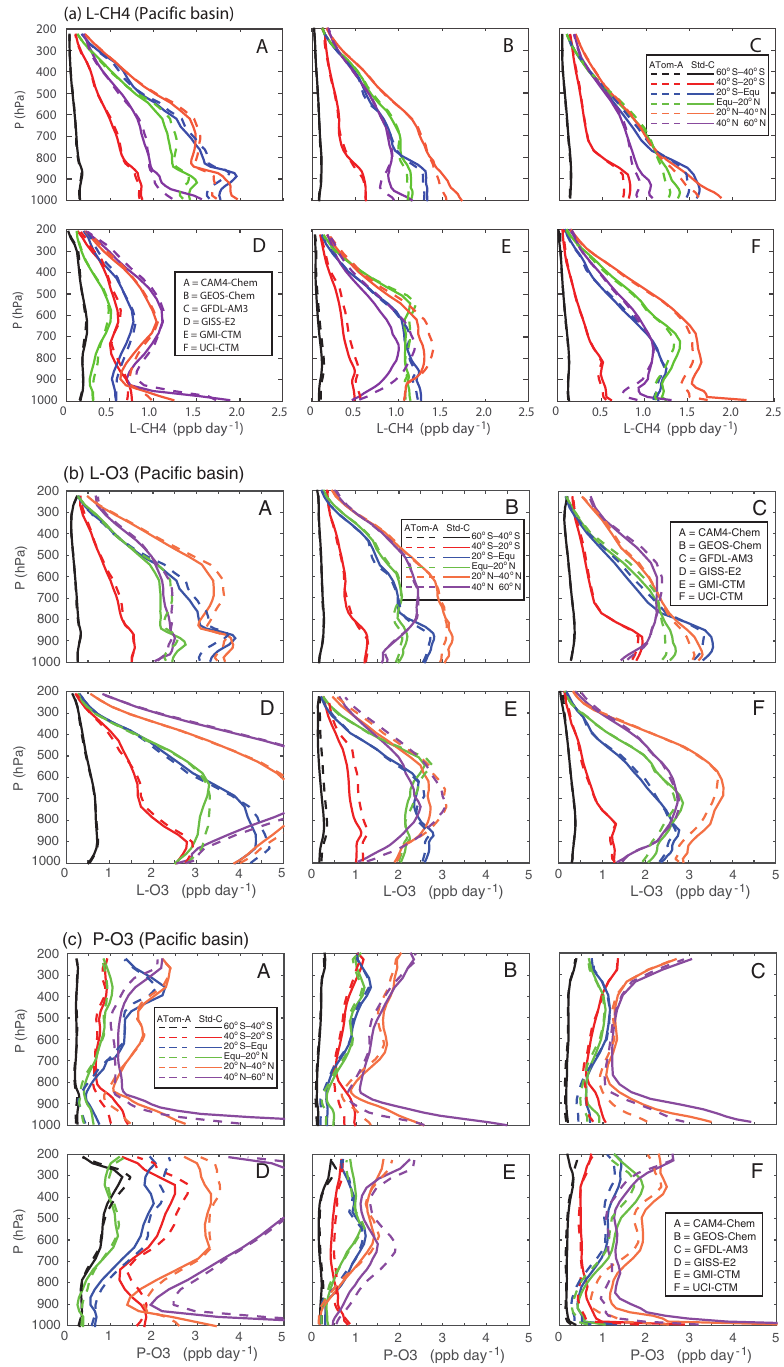
Figure 3. Profiles of reactivity (ppb day − 1 ) for loss of CH 4 (L-CH4, top panel), loss of O 3 (L-O3, middle panel), and production of O 3 (P-O3, bottom panel) from six global models (Table 1). Cells from each model grid are averaged over 20 ◦ latitude domains (different colors, see legend), longitudes from 150 to 210 ◦ E, and for the single day of 16 August. Years vary by model, see text. Solid lines are standard model simulations (C-runs) with the values representing air that passed through the cell over 24h. Dashed lines are the no-transport, no-emissions A-runs that keep the initialized chemical values in the same cell over